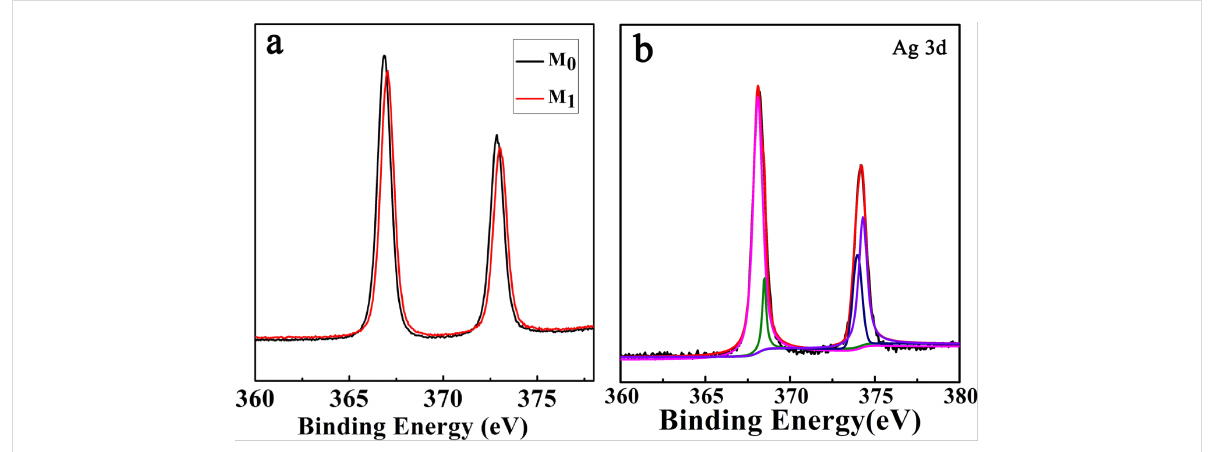
Figure 4: (a) XPS spectra of M 0 and M 1 ; (b) XPS peaks of Ag 3d 5/2 and Ag 3d 3/2 of M 1 .